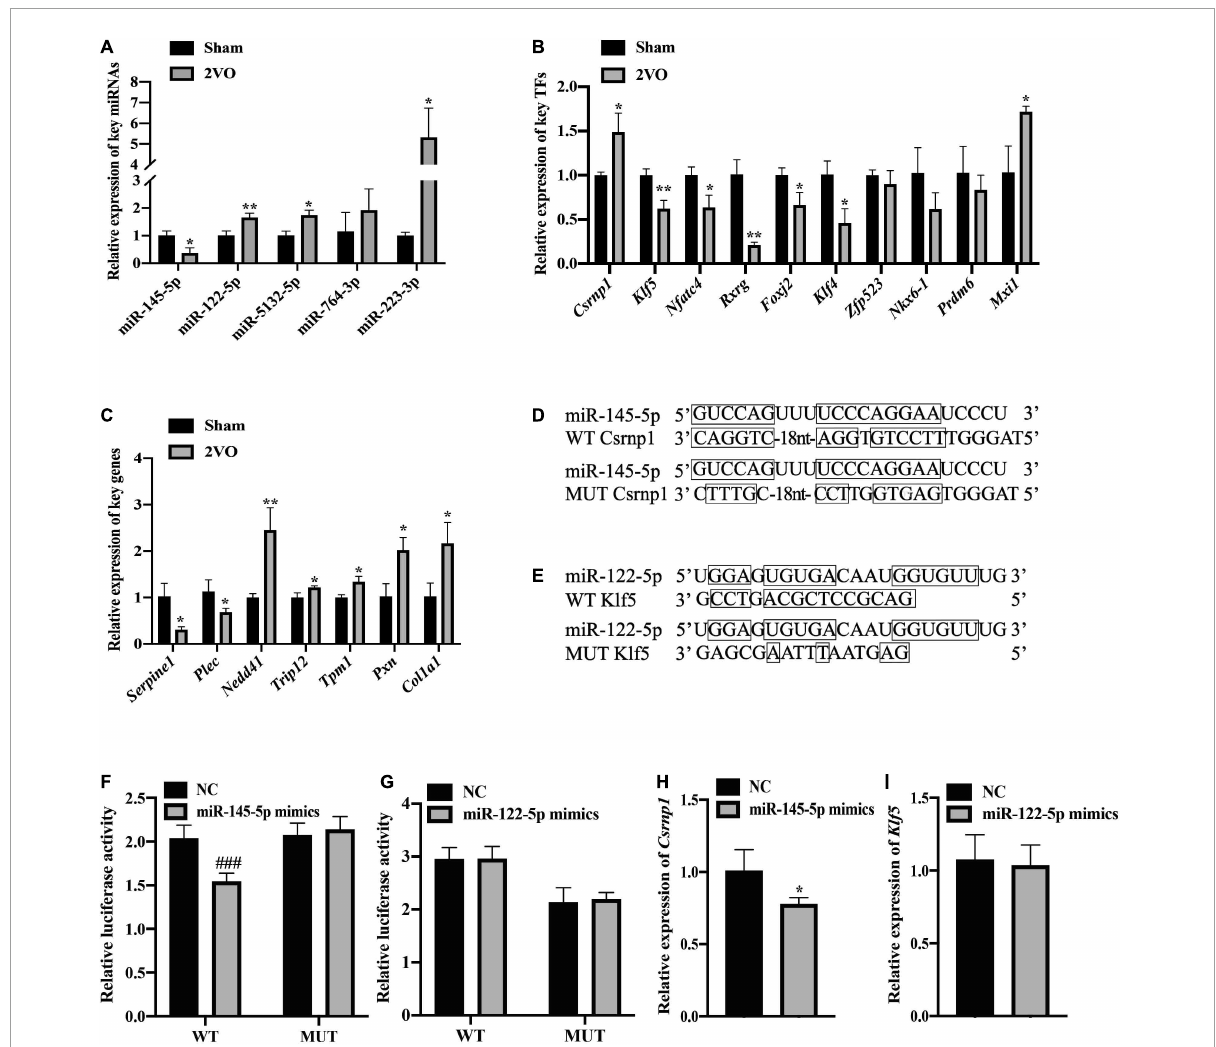
FIGURE10 Validation of the expression and regulatory relationship. (A) Verification of the differential expression of the key miRNAs using qRT-PCR ( n = 3). (B) Relative expression of the key TFs in the cortex of the rats with 2VO compared with the sham rats using qRT-PCR analysis ( n = 3). (C) Relative expression of the key genes using qRT-PCR analysis ( n = 3). (D) Wild-type (WT) or mutant-type (MUT) binding sites for the combination of miR-145-5p and Csrnp1 in the dual-luciferase reporter assay. (E) Binding sites of the wild or mutant type of miR-122-5p and Klf5 . (F) Direct interaction of miR-145-5p/ Csrnp1 by dual-luciferase reporter assay ( n = 6). (G) No direct interaction of miR-122-5p/ Klf5 by dual-luciferase reporter assay ( n = 6). (H) Significant decrease of the Csrnp1 expression in the presence of miR-145-5p mimics. (I) No difference in the Klf5 expression in the presence of miR-122-5p. Results are presented as mean ± SD. * P < 0.05, ** P < 0.01 vs . Sham. ### P < 0.001 vs .